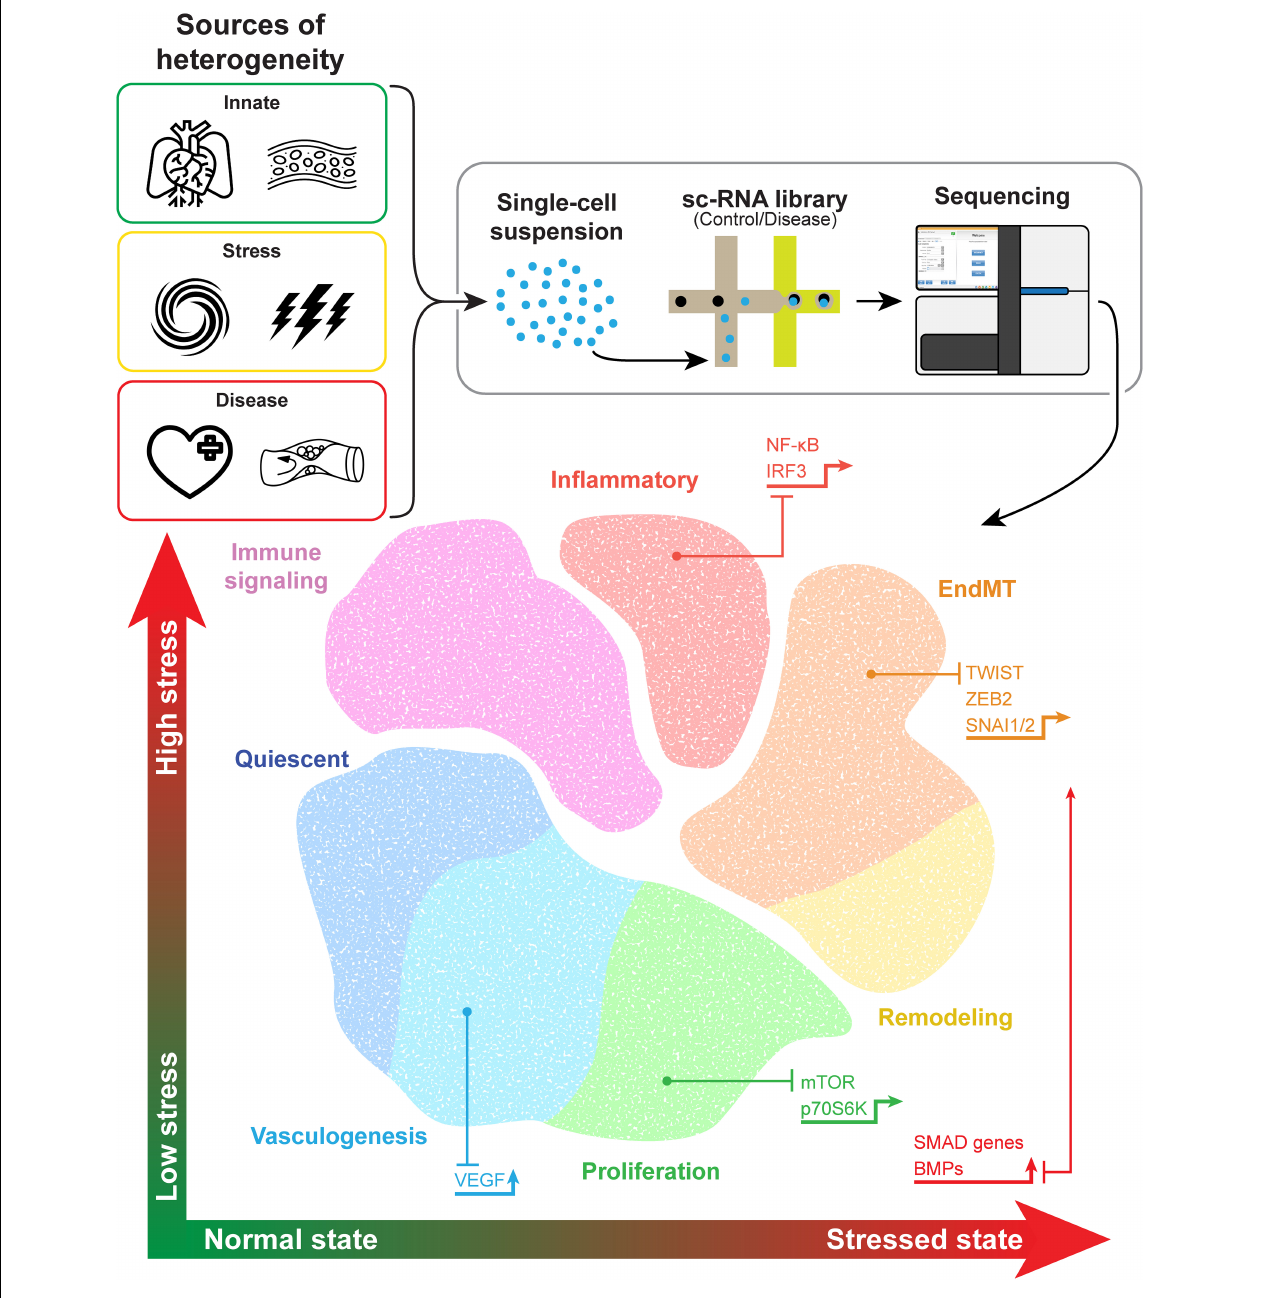
FIGURE 1 | Endothelial cell heterogeneity revealed by cell-specific sequencing. Endothelial cells (ECs) exhibit phenotypic differences that stem from inherent organo-specific, vessel-specific, and site-specific functions. Additionally, ECs can change phenotypes in response to cell stress or vascular disease, with representative pathways and transcription factors promoting different phenotypes, as shown with the associated arrows. The isolation and sequencing of single cells allow for improved precision in determining different endothelial cell phenotypes or cell states. Although distinct phenotypes have been identified, some features overlap, such as proliferative stalk cells in vasculogenesis. Evidence supports a potential phenotypic spectrum of some types of ECs, such as those involved in remodeling and endothelial-mesenchymal transition.